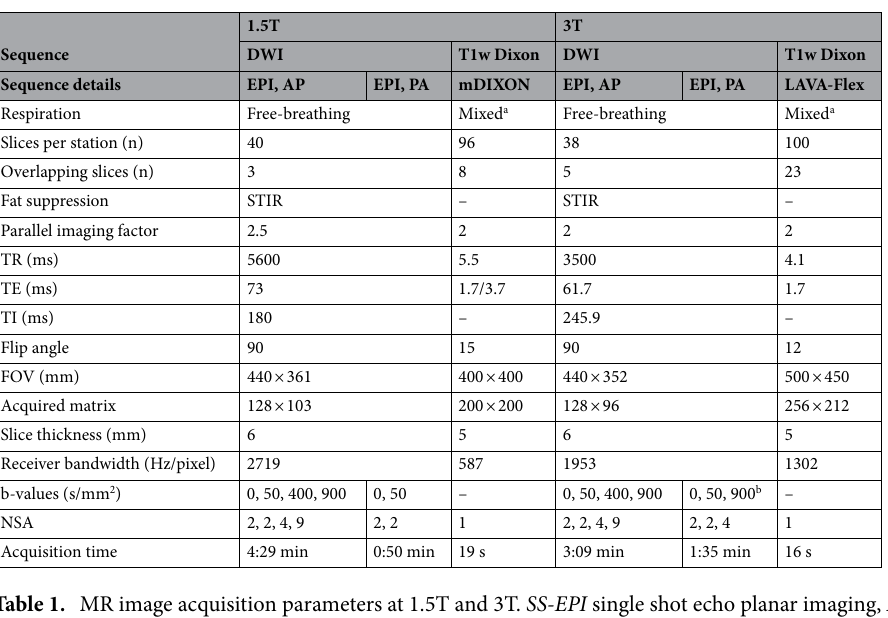
Table 1. MR image acquisition parameters at 1.5T and 3T. SS-EPI single shot echo planar imaging, AP anterior–posterior, PA posterior-anterior, NSA number of signal averages. a Breath-hold for neck, chest and abdomen stations, free-breathing for head, pelvis and legs stations. b b900 added to get an equal number of segments for the AP and PA acquisitions, enabling the same TR to be set.